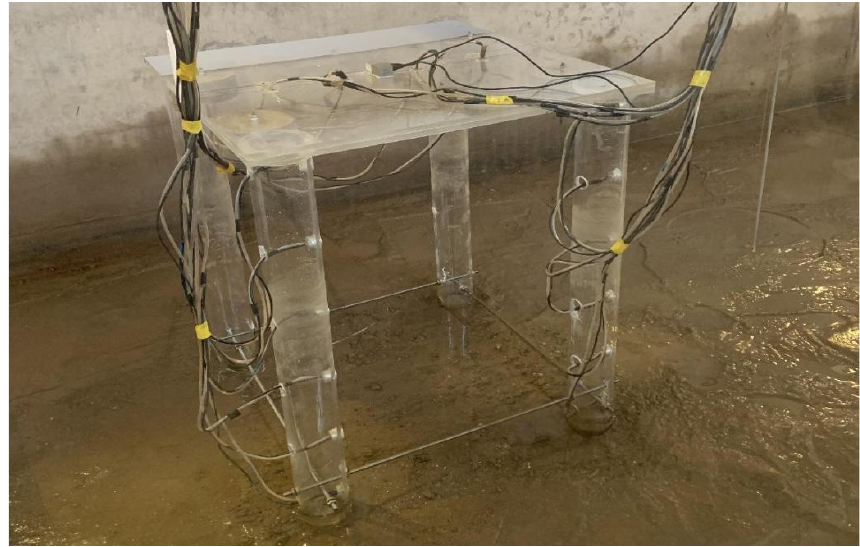
Figure 4. Photo after the preparation of model A.